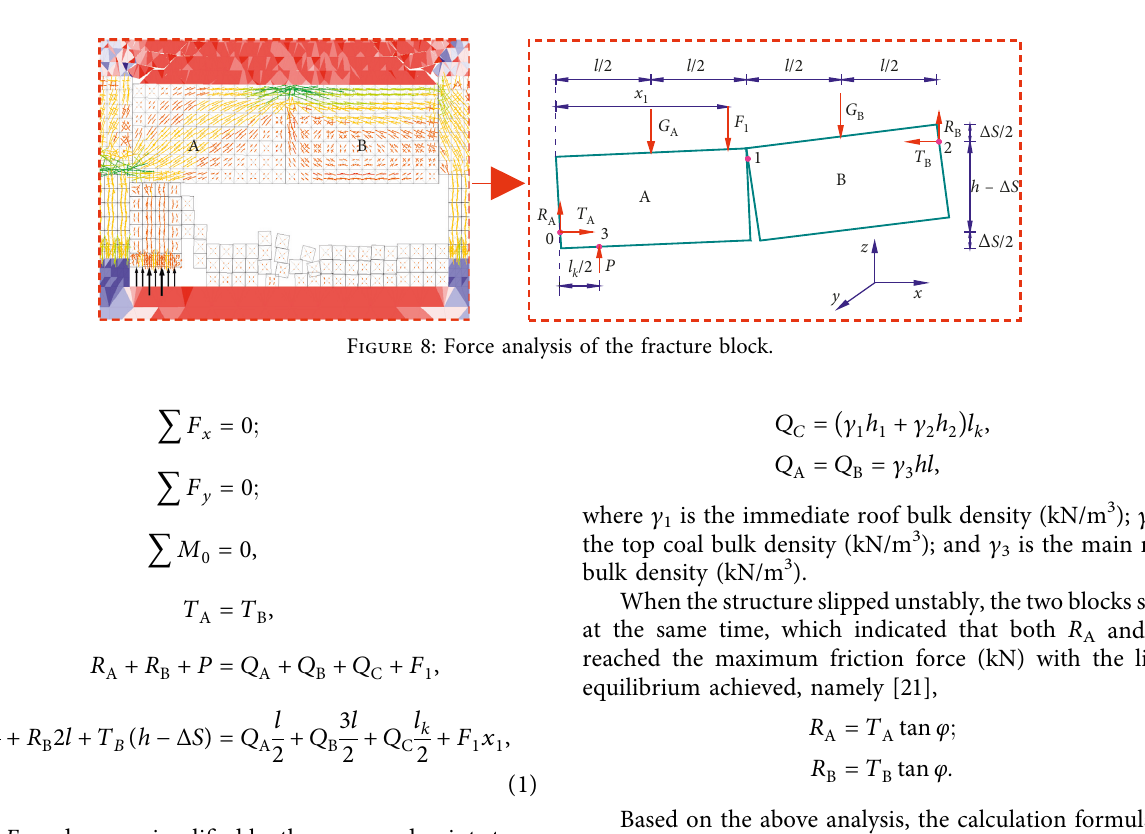
Figure 7: Surrounding rock stress tensors when main roof first weighting.